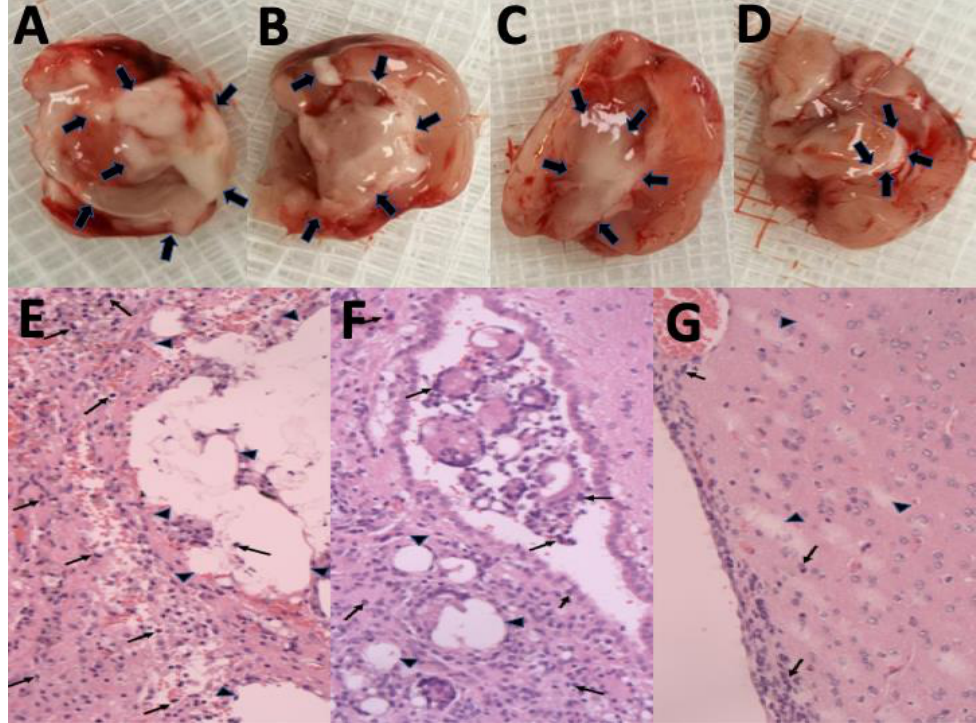
Figure 5. Degradation of SN-38-embedded poly[( d , l )-lactide- co -glycolide] microparticles (SMPs) and histological examination of brain tissue. Overall appearance at ( A ) 1 week, ( B ) 4 weeks, ( C ) 6 weeks, and ( D ) 8 weeks, after stereotactic SMP injection into the brain parenchyma. The injected SMPs (indicated with black arrows) were denser and greater in number during the first few weeks. Only a few SMPs were observed at the end of the study. Hematoxylin-and-eosin (H&E)-stained ipsilateral brain tissues obtained at ( E ) 1 week, ( F ) 4 weeks, and ( G ) 8 weeks. The SMPs (indicated by triangles) became larger and more concentrated, and gradually degraded over time. Only a few tiny residual particles were observed at 8 weeks postinjection. A focal and temporary inflammation reaction (accumulation of numerous inflamed leukocytes, indicated by small arrows) occurred at the injected area. No clear inflammation was observed in the noninjected areas in the histological examination. Magnification = 100×.